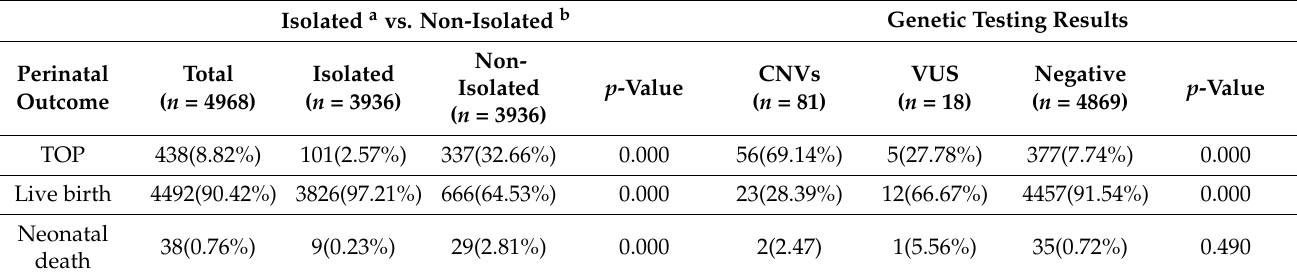
Table 3. The perinatal outcomes in fetuses with 16p11.2 microdeletion. Isolated a vs. Non-Isolated b Genetic Testing